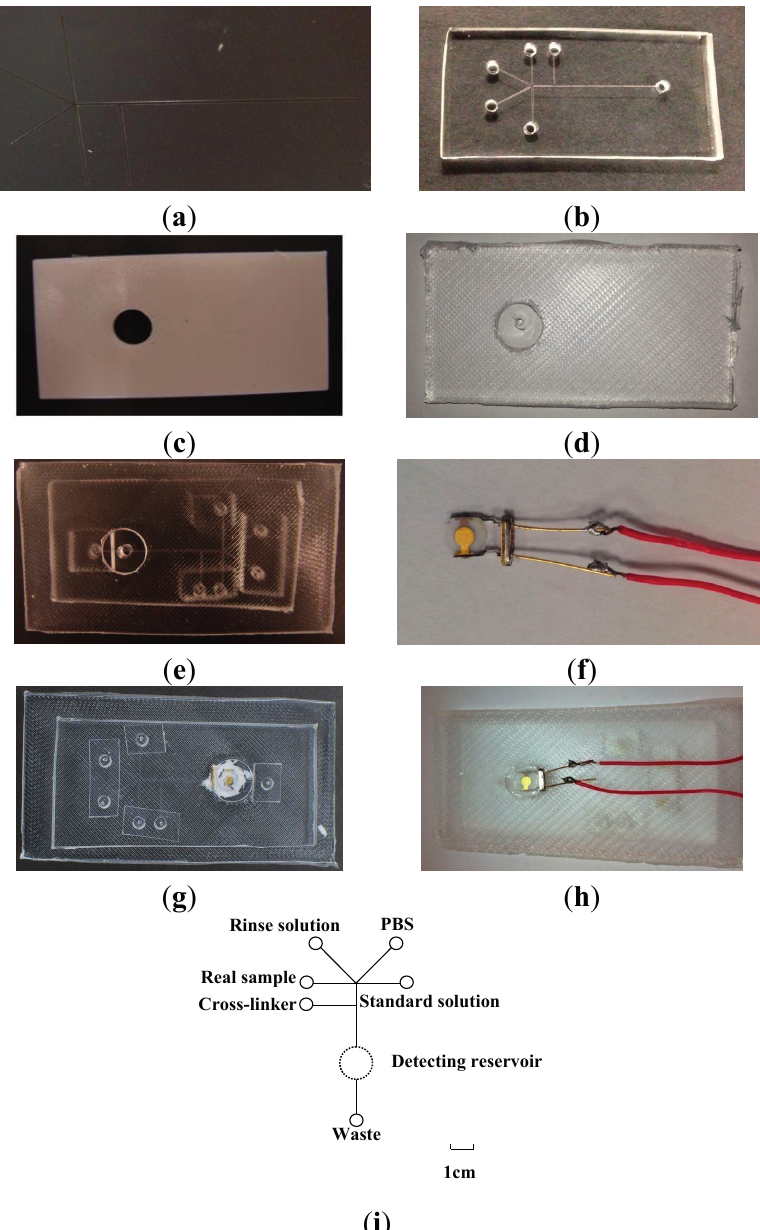
Figure 2. Photographs of ( a ) Si mold; ( b ) ABS mold; ( c ) PDMS microfluidic chip; ( d ) mounting PDMS slab; ( e ) PDMS-PDMS microfluidic device; ( f ) mQCM; ( g ) front-side and ( h ) backside of PDMS-mQCM microfluidic system; ( i ) Layout of an integrated PDMS-mQCM microfluidic system; standard solution: from 0.025 µM to 5.2 µM A β 42 . Scale bar: 1